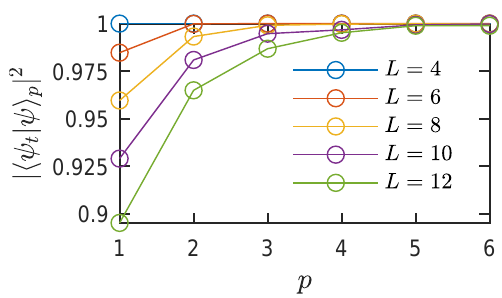
Figure 5: Fidelities in the preparation of ground states of AFM spin-1 / 2 Heisenberg chains of various sizes using